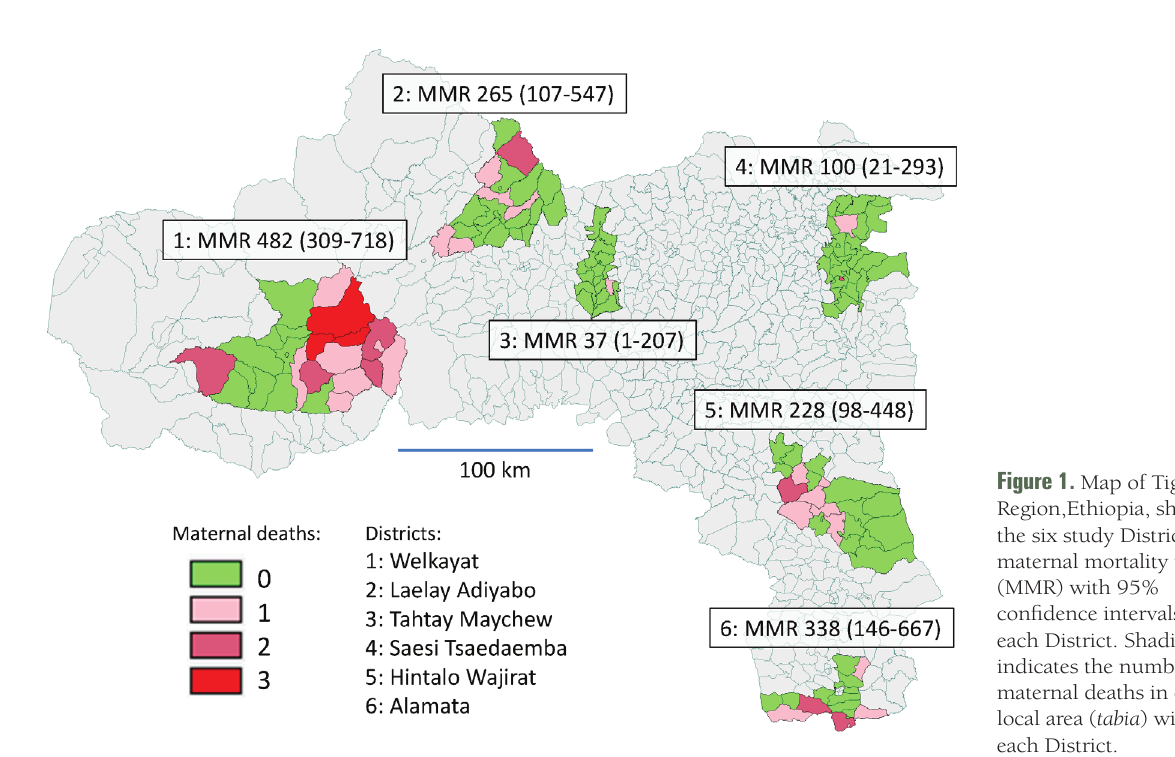
Figure 1. Map of Tigray Region,Ethiopia, showing the six study Districts and maternal mortality ratios (MMR) with 95% confidence intervals for each District. Shading indicates the numbers of maternal deaths in each local area ( tabia ) within each